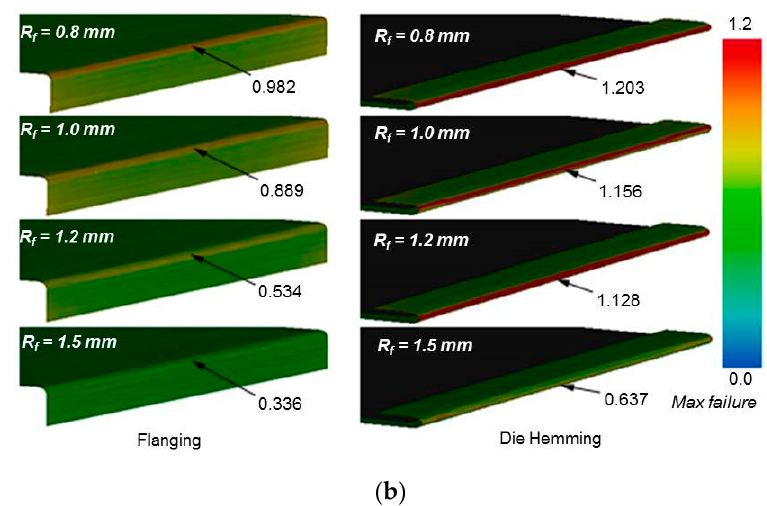
Figure 14. Experimental and simulation results based on different R f in the flanging and die hemming process: ( a ) convex surface images of the outer panels and ( b ) Max failure indicator in simulation.